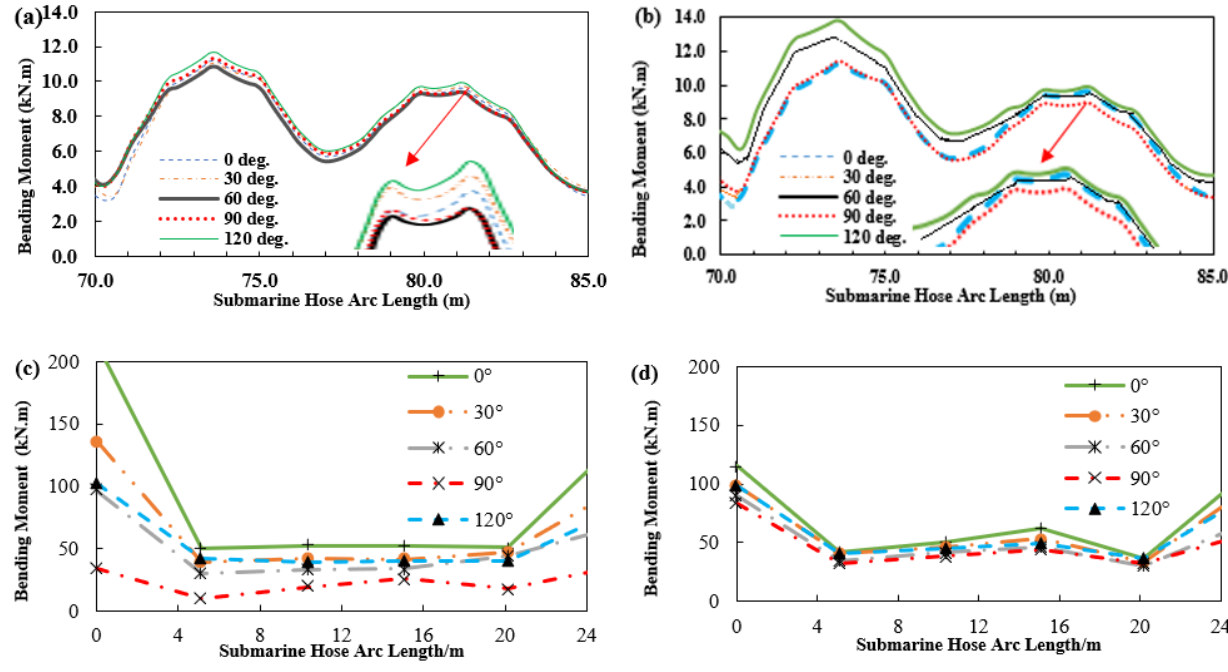
Figure 24. Influence of hydrodynamic loads on the bending moment of the submarine hose. ( a ) Coupled model for hose bending moment in Lazy-S config. ( b ) Uncoupled hose bending moment in Lazy-S config. ( c ) Coupled hose bending moment in Chinese-lantern config. ( d ) Uncoupled hose bending moment in Chinese-lantern config.